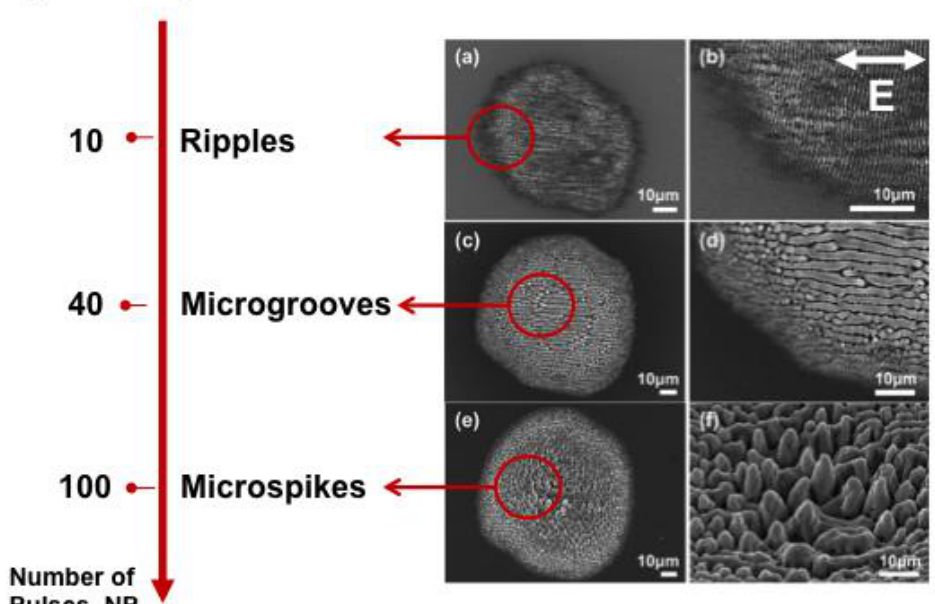
Figure 3. Di ff erent types of femtosecond (FS) laser-induced self-organized periodic surface structures Figure 3. Different types of femtosecond (FS) laser-induced self-organized periodic surface (LIPSS) structures (LIPSS) [2].